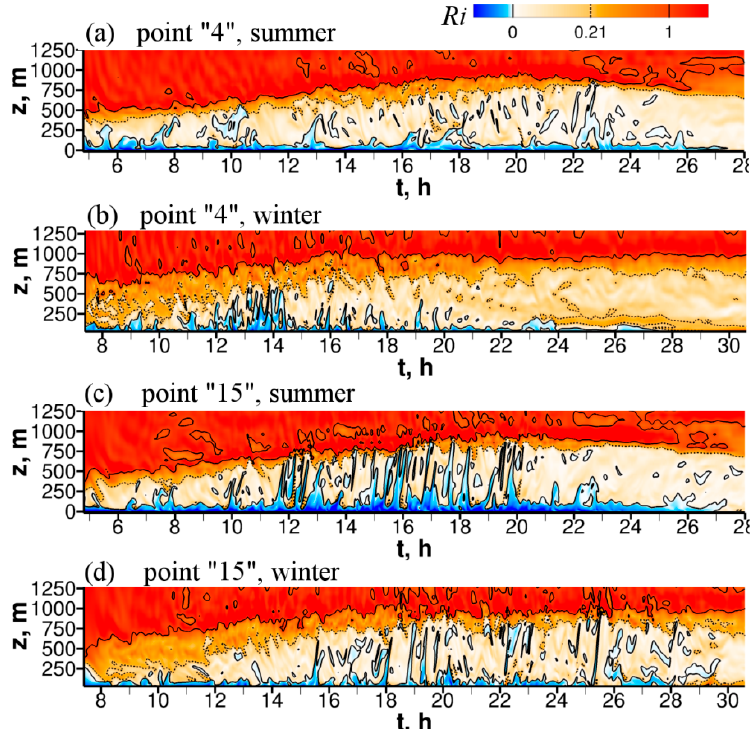
Figure 16. Temporal evolution of Richardson number distribution for several points (shown in Figure 1). ( a , c ) Summer case; ( b,d ) Winter